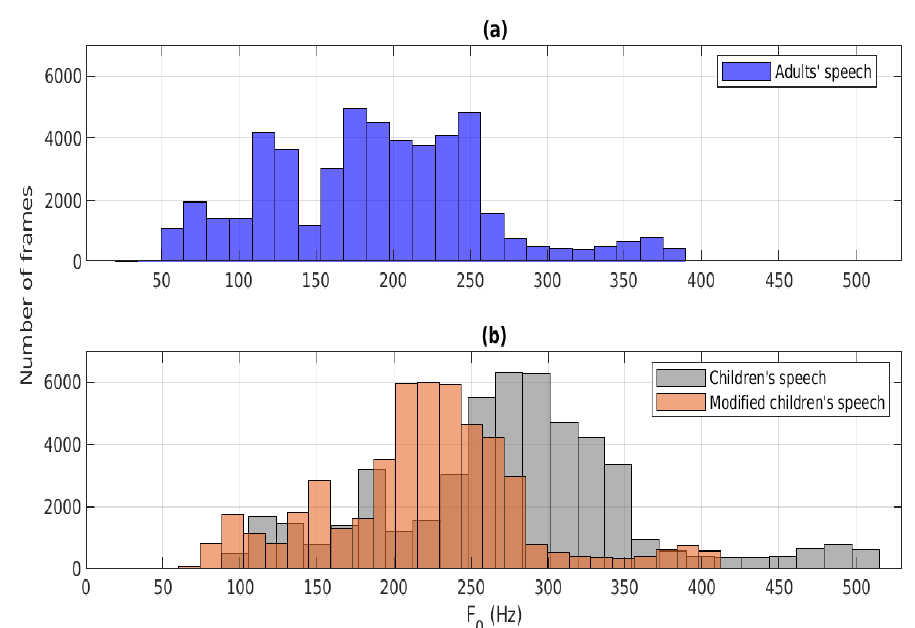
Figure 3. F 0 histograms for ( a ) adults’ speech, ( b ) children’s speech and modified children’s speech processed by the F 0 modification